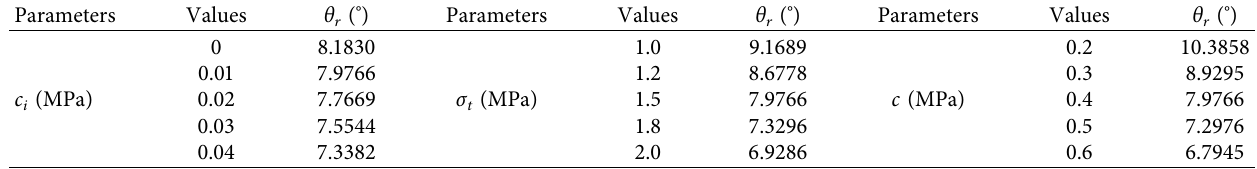
Table 7: Sensibility analyses of the mechanical parameters of the rock mass of the slate slope in South Anhui. Parameters Values θ r ( ° ) Parameters 0.01